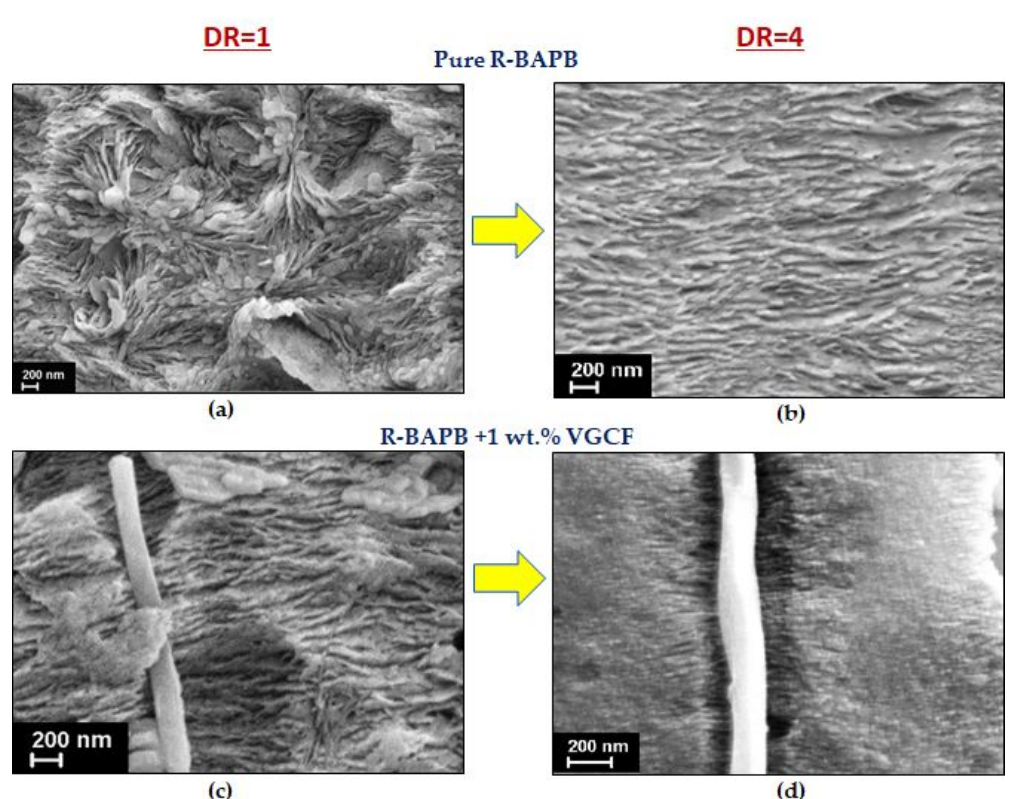
Figure 4. SEM images of the surface of crystallized fibers based on R-BAPB polyimide with the addition of 1 wt.% VGCF before (DR = 1) and after orientational drawing (DR = 4). The direction of fiber orientation was vertical. The pure R-BAPB fiber: ( a ) before orientation drawing DR = 1, ( b ) after drawing up to DR = 4; the composite R-BAPB fiber filled with 1 wt.% VGCF: ( c ) before orientation drawing DR = 1, ( d ) after drawing up to DR = 4.